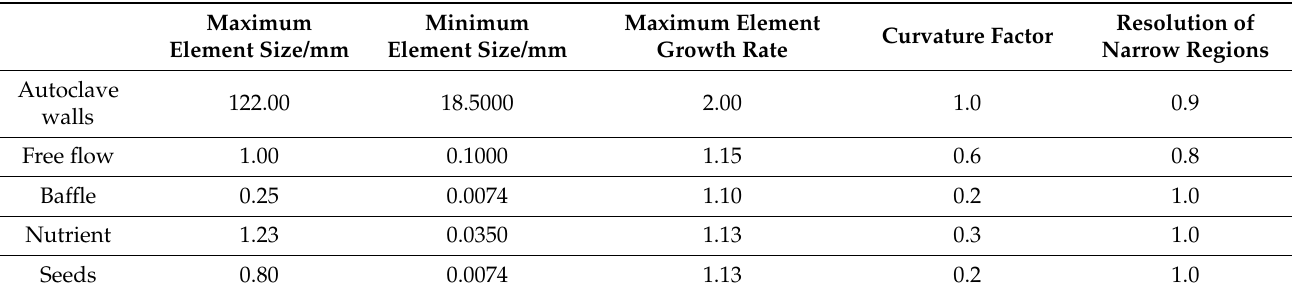
Table 6. Parameters applied for mesh